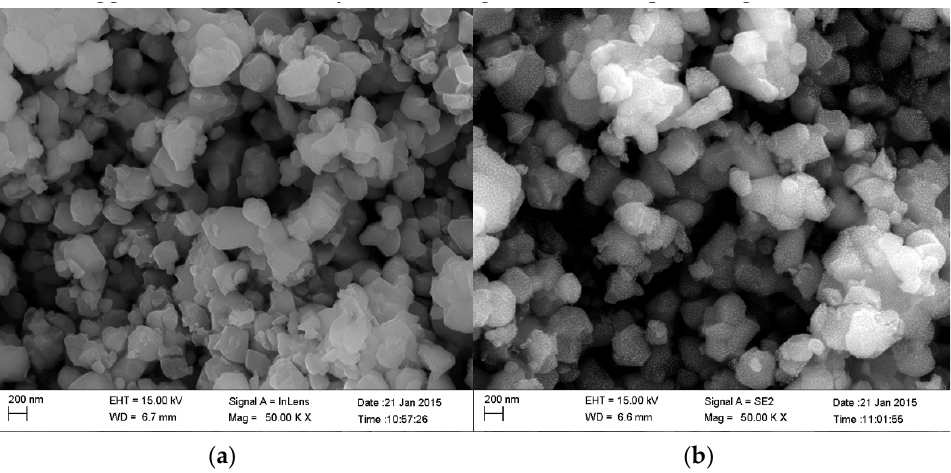
Figure 11. SEM images of hydrolyzing product at different times: ( a ) 100 °C, 30 min and ( b ) 100 °C, 120 min.